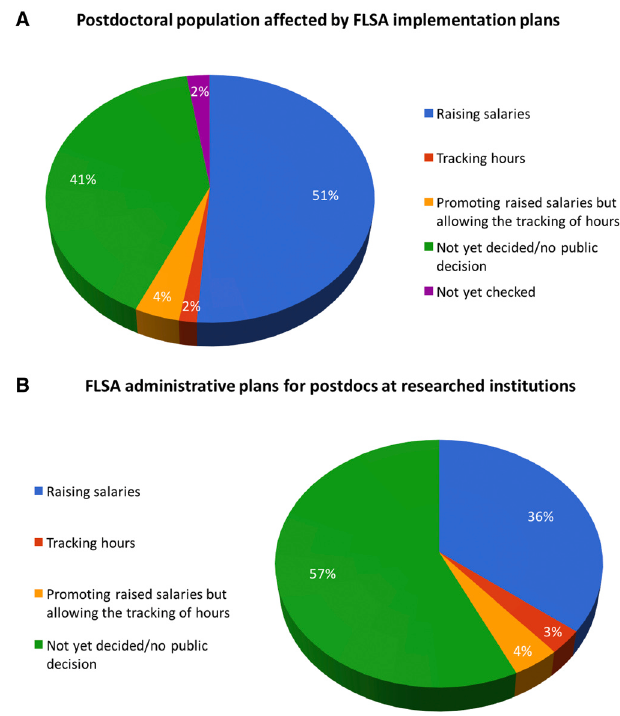
Figure 2. The predicted effect of FLSA updates and institutional decisions on the Science, Engineering and Health postdoctoral workforce as of November 1st 2016. Pie charts show the percentage of the postdoctoral population at institutions implementing various plans for FLSA ( A ) and the percentage of institutions implementing various plans for FLSA (includes institutions so far researched for the FLSA and postdocs resource) ( B